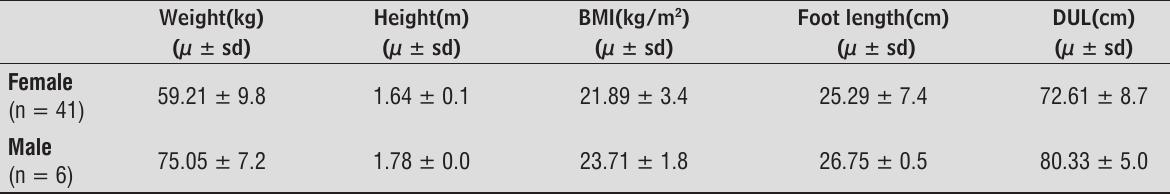
Table 1 - Anthropometric characteristics